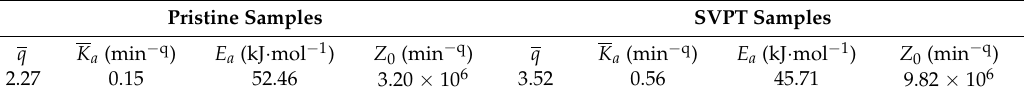
Table 1. Crystallization kinetics parameters of pristine samples and the samples subjected to the SVPT at 5 W for 1 min, extracted from the TG data. K and q are the average values obtained from four TG measurements at 70, 80, 90, and 100 ◦ C.